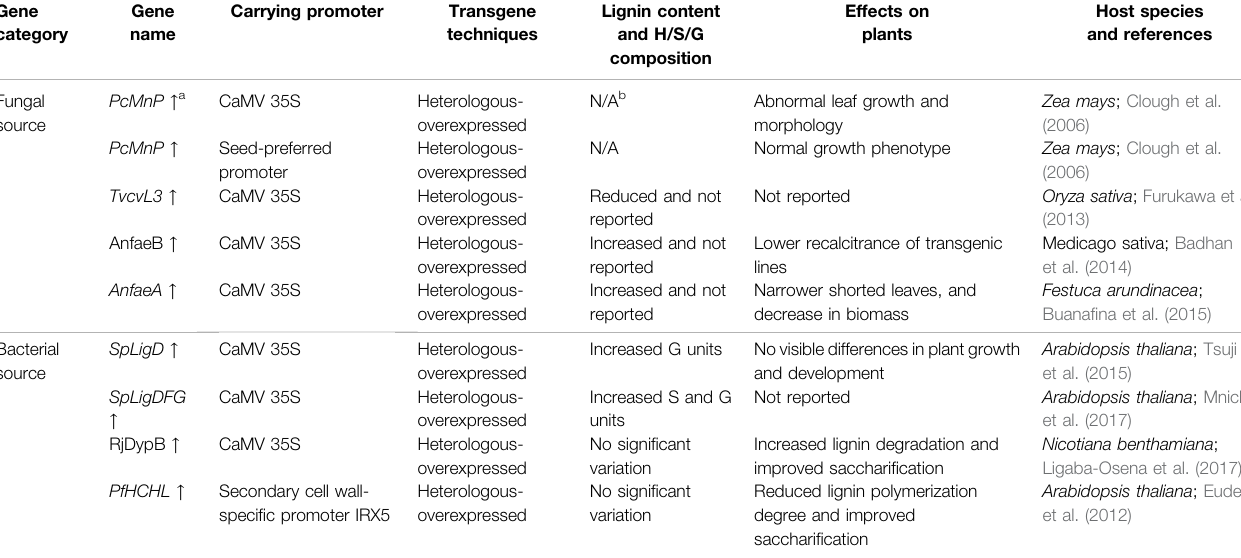
TABLE 2 | Heterologous genetic modi fi cation of microbial ligninolytic enzymes in